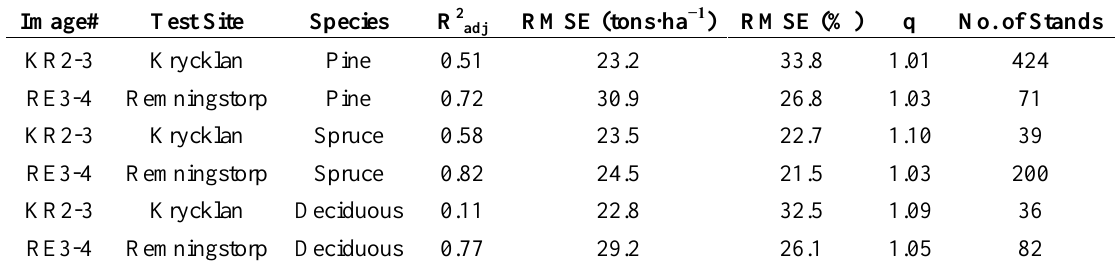
Table 7. Species-specific results of AGB for the image pairs KR2-3 and RE3-4.